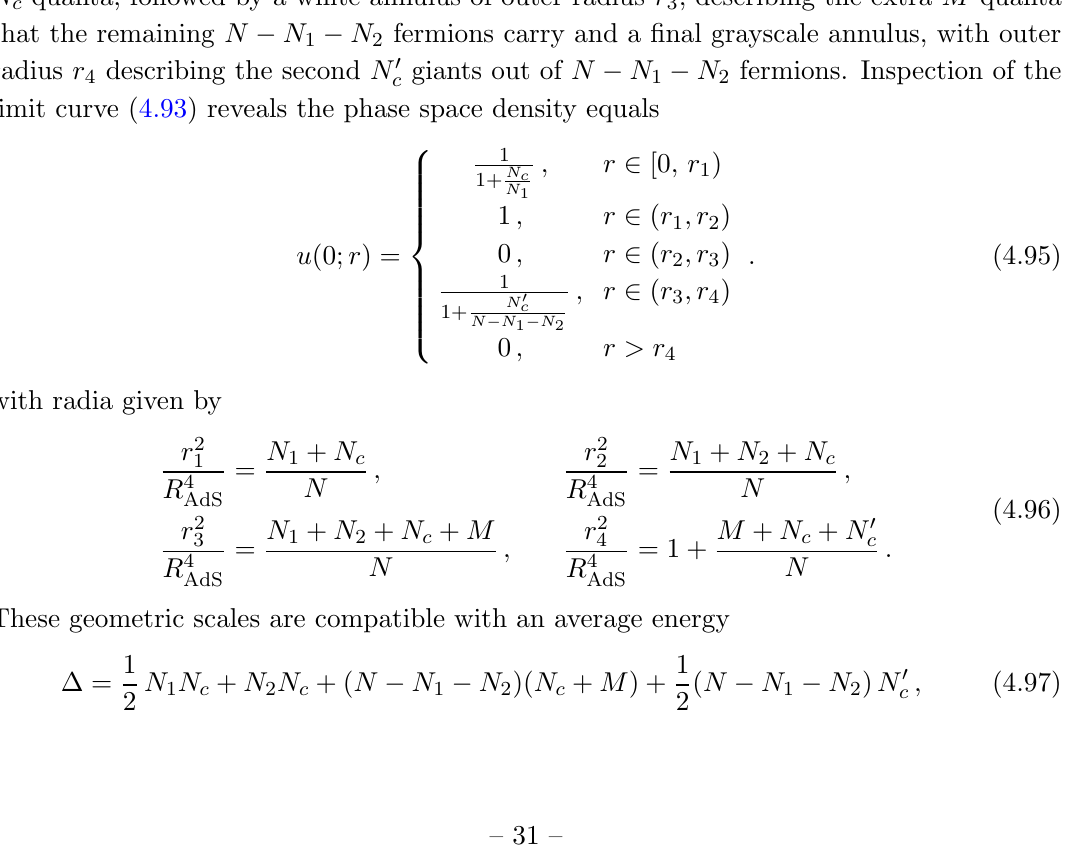
giants separated by a gap c